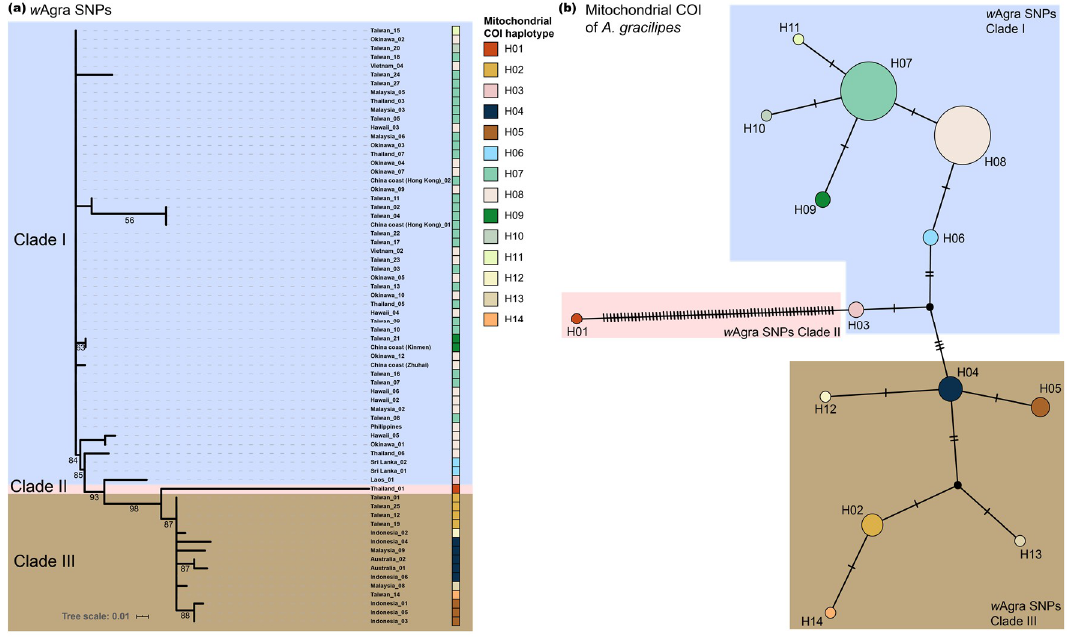
Figure 2. ( a ) Wolbachia ( w Agra) SNPs phylogenetic tree based on Maximum Likelihood method. The mitochondrial COI haplotype of each sample is indicated in color boxes following individual name. Numbers at node indicate bootstrap support values (1000 replicates). Tree branches with < 50% bootstrap supporting value were removed. ( b ) The median-joining network analysis of A . gracilipes mitochondrial COI haplotypes. The color shading depicts the w Agra SNPs clade displayed in ( a ). Circle area is proportional to the number of individuals carrying a given haplotype.